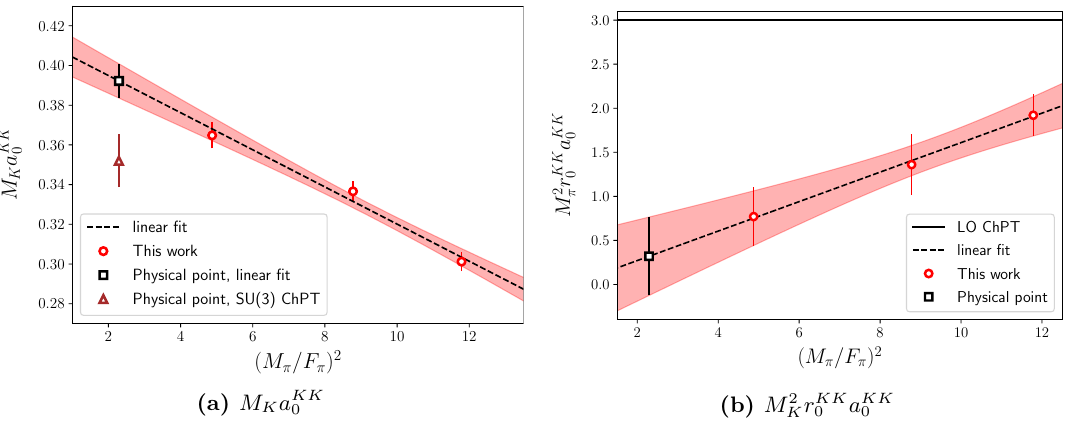
Figure 11. Results for the s -wave two-kaon scattering length and effective range. Notation as in figure 5, except that in the left panel we include, with an empty triangle, the result for the chiral extrapolation from an SU(3) ChPT fit to both kaon and pion scattering